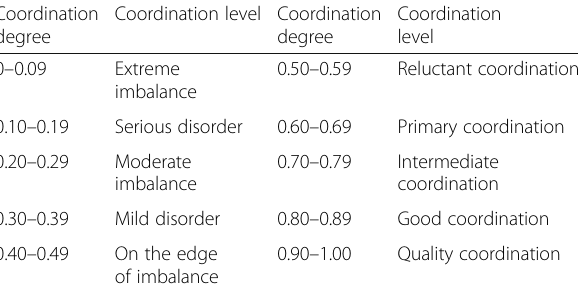
Table 7 Coupling degree evaluation criteria